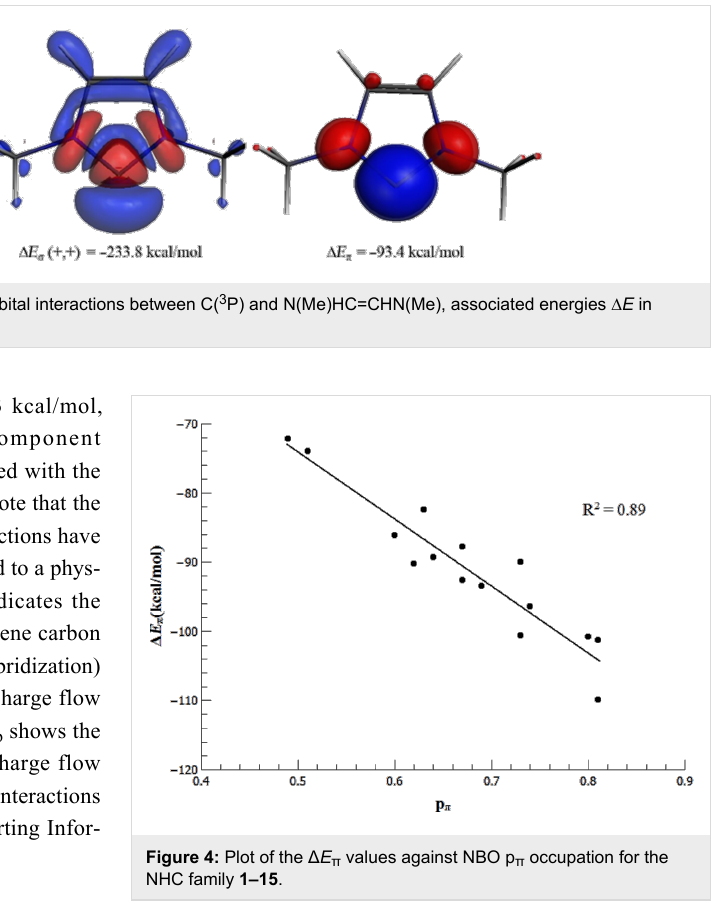
NHC family 1–15 .